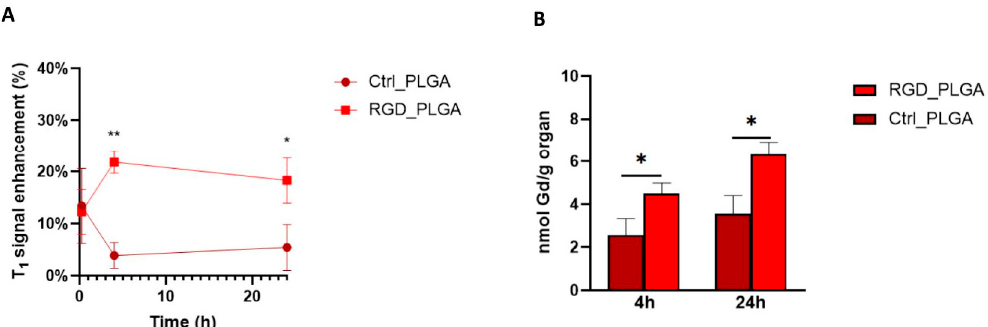
Figure 5. In vivo biodistribution of RGD_PLGA and Ctrl_PLGA. ( A ) T 1enh in the tumor region at different time points upon administration of RGD_PLGA or Ctrl_PLGA. ( B ) Quantification of Gd retained in the tumor by inductively coupled plasma mass spectrometry (ICP-MS), at t = 4 h and t = 24 h. *, p < 0.05; **, p < 0.01, Student’s t